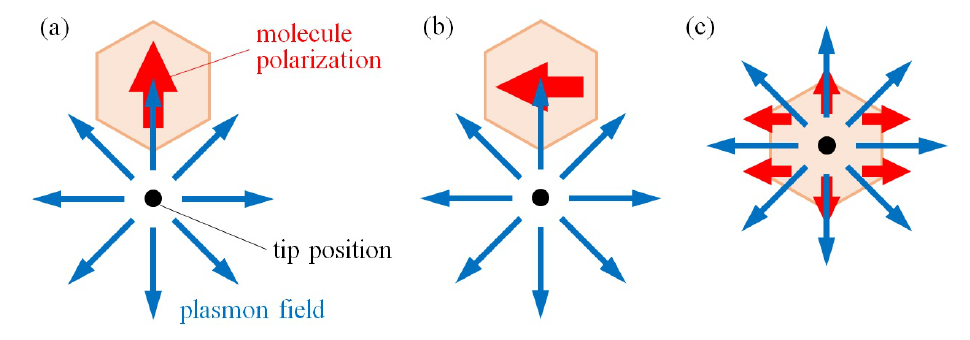
Figure 4. Excitable conditions of a molecule by plasmon (top view). The hexagon and red arrows represent the molecule and molecular polarization, respectively. The black dot represents the tip position and the blue arrows are the electric field vector of the localized plasmon induced at the tip-substrate nanogap. ( a , b ) show the excitable and non-excitable tip position conditions for the allowed transition of the molecule, as shown in Figure 3f,g, respectively. ( c ) shows the excitable tip position condition for a forbidden transition of the molecule, as shown in Figure 3j.